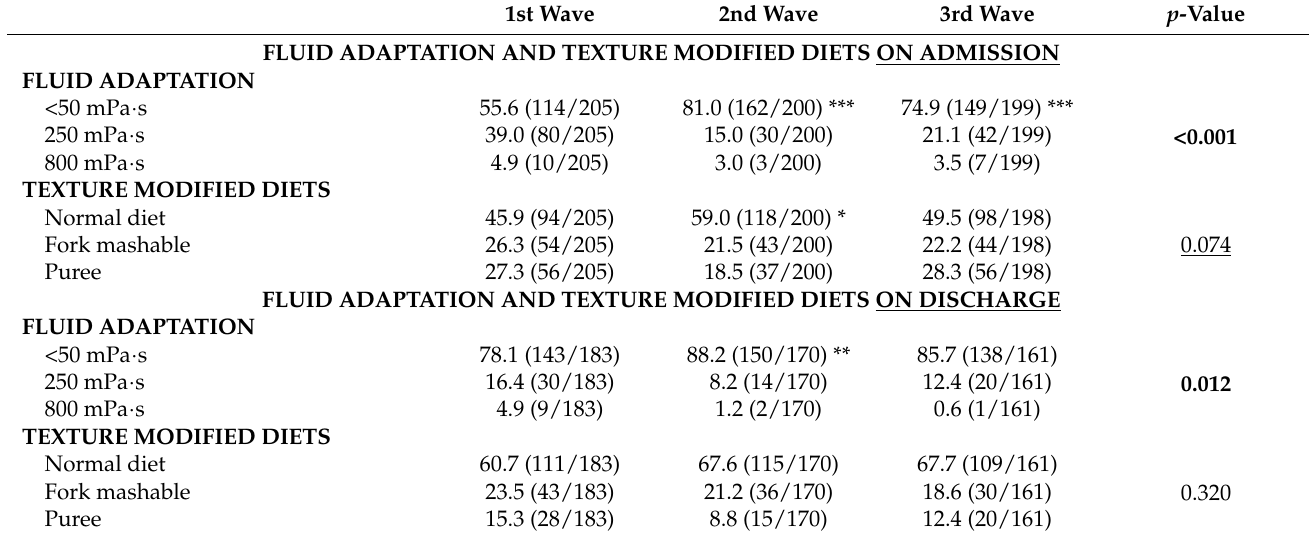
Figure 3. Consort study flow chart for patients included in the study in each of the first three waves